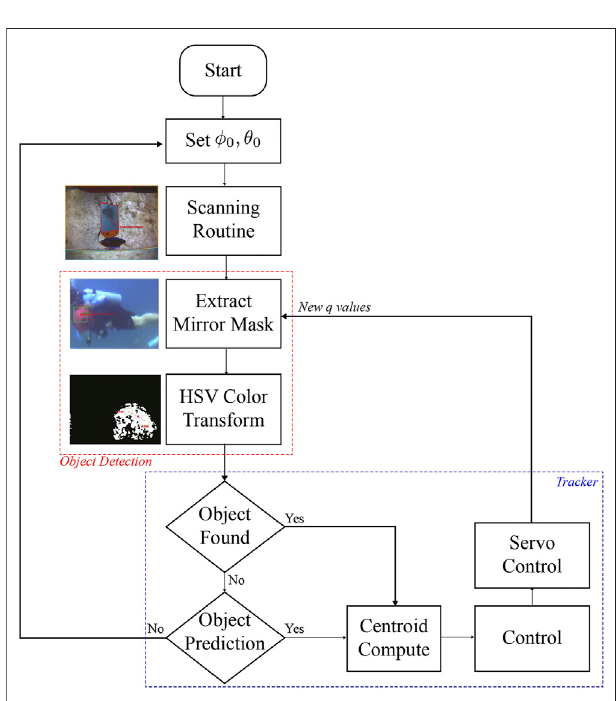
FIGURE 12 | Flowchart of the active tracker for experimental trials. The red line frames the process of detecting an object from colored spots in the HSV space. The blue line frames the system control